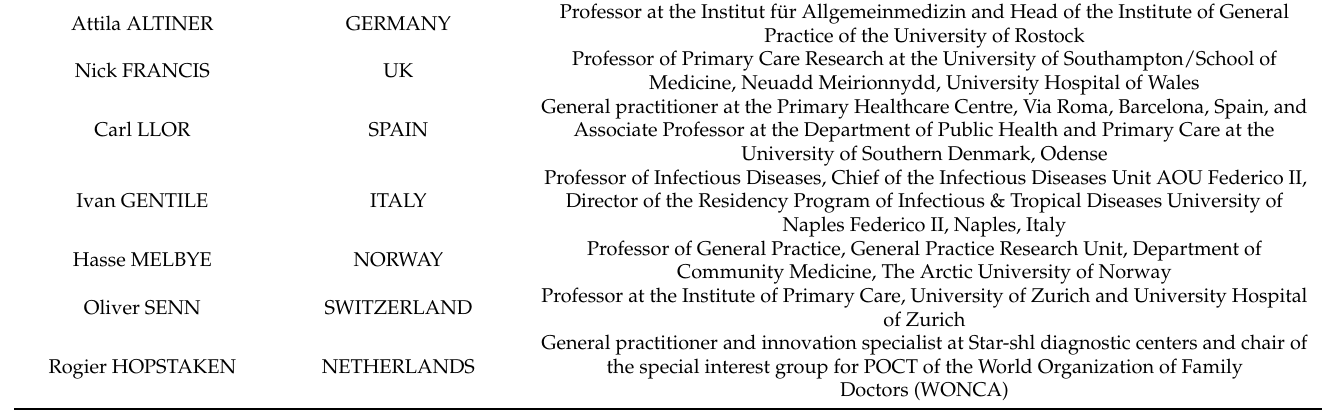
Table 1. The Expert